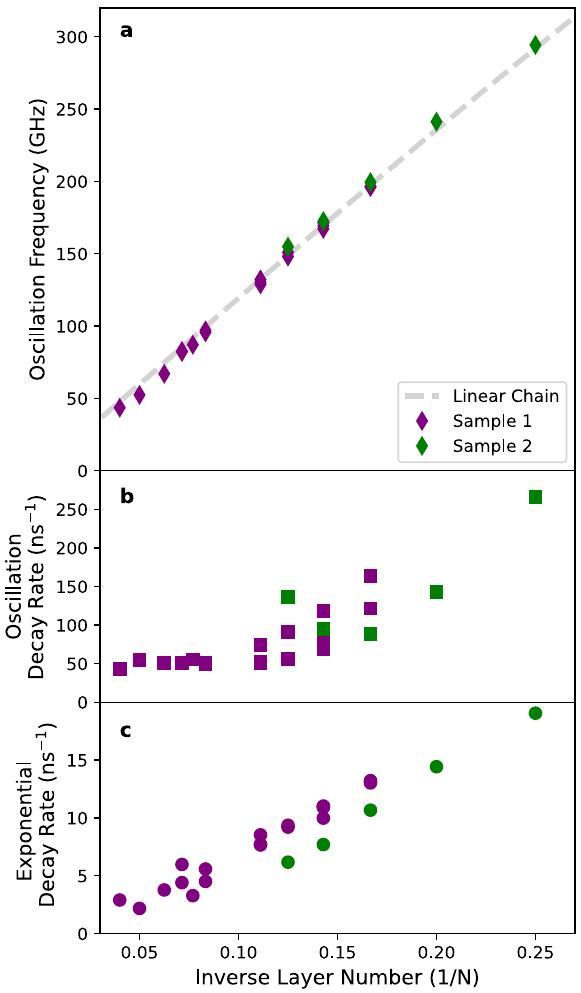
Fig. 3 Thickness dependence of various parameters of the time- resolved re fl ectivity data. The oscillation frequency ( a ) increases as the sample becomes thinner and fi ts well to a linear-chain model (cid:3) (cid:4) f N ð Þ ¼ f 0 ; B sin π with f 0 ,B = 760 GHz. The decay rates of both the 2 N oscillatory component ( b ) and the simple exponentially decaying component ( c ) also increase for thinner samples, with the latter being particularly noticeable. Note that statistical uncertainties from fi tting are very small ( ≈ 0.1%, 1% and 0.5% for points in a , b and c respectively, all within marker sizes), but practical uncertainties are clearly much larger due to factors such as variation across sample